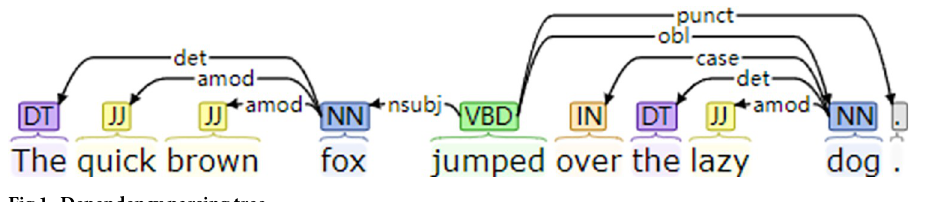
Fig 1. Dependency parsing